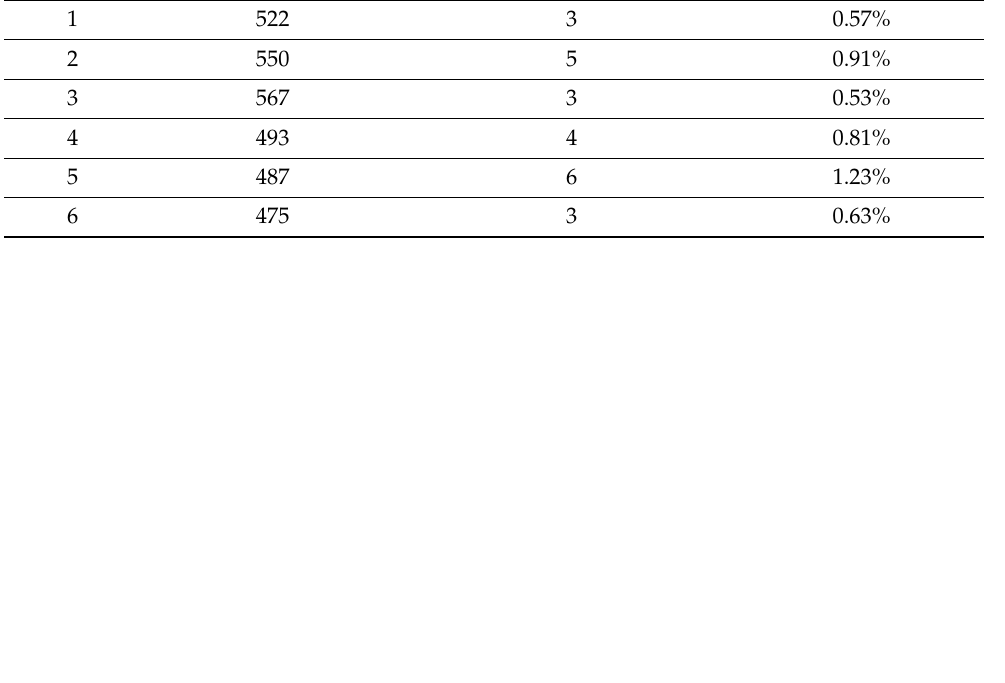
Figure 3. The first round of rVACV L1c-Ig-Turbo-TK-eGFP plaque selection ( a – d ). ( a ) Fluorescent image of the recombinant virus-infected CV-1 cells in 96-well plates after two days of incubation scanned by the IncuCyte ® S3, scale bar = 27.4 mm. ( b ) Image enlargement (IE) from ( a ) B5 well. ( c ) IE from ( a ) F2 well. ( d ) IE from ( a ) F12 well. ( b – d ) The scale bars represent 2.4 mm. Table 1. Statistical analysis of eGFP-positive plaques per 96-well plate. Total Number of Viral Plate No. Plate